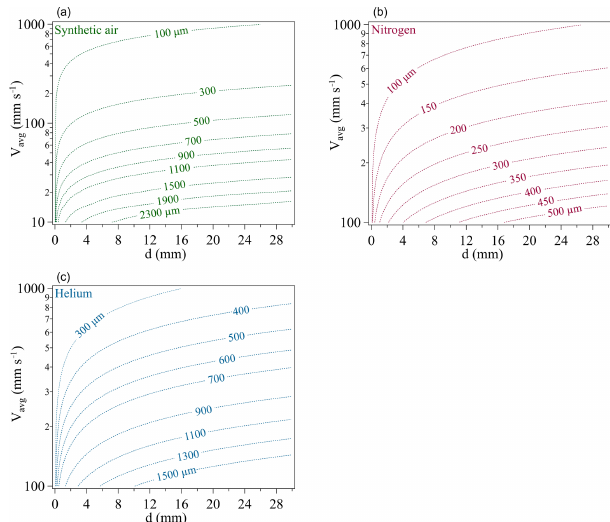
Figure 5. Calculated critical height δ c (dash-dotted lines) versus varying tube diameter d and flow velocity V avg in flow tube ex- periments with carrier gases of synthetic air (a) , nitrogen (b) , and helium (c) , respectively.